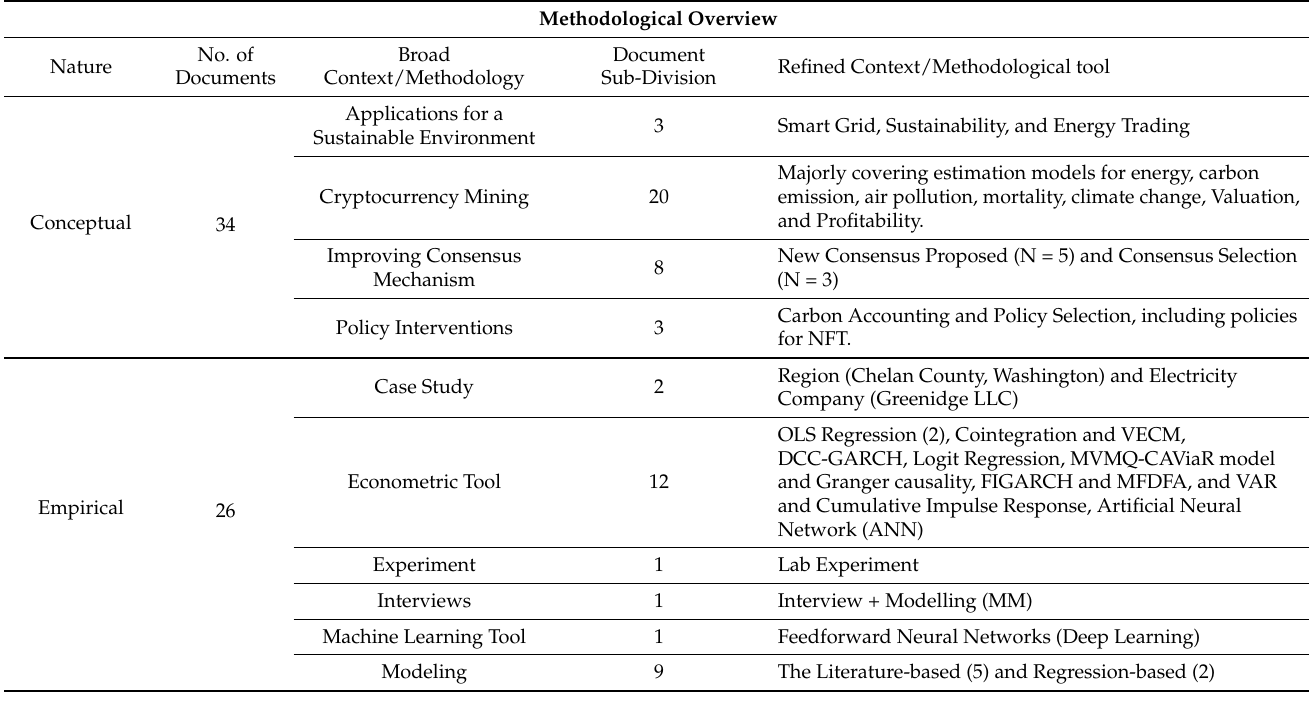
Table 9. Methods adopted in the literature.